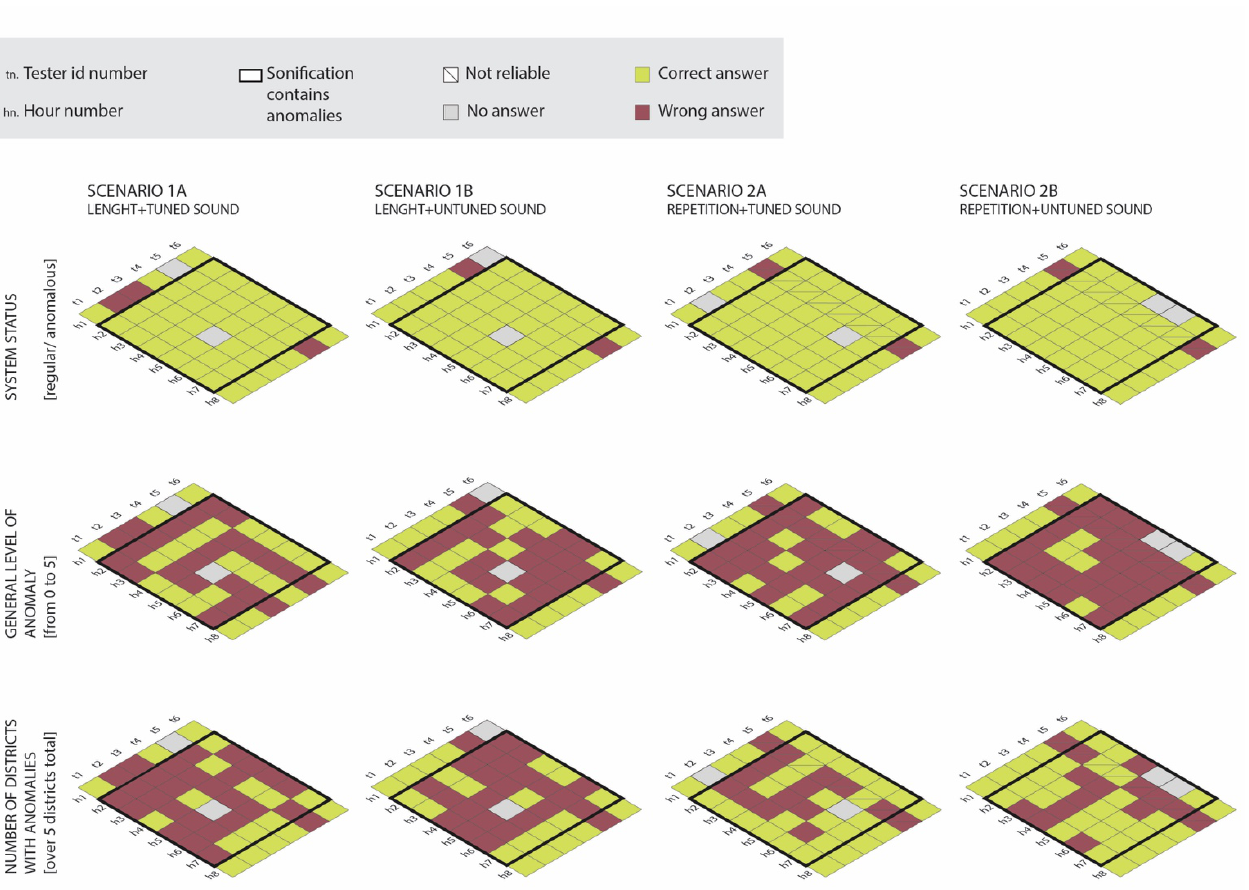
Figure 3 . Analysis of quantitative